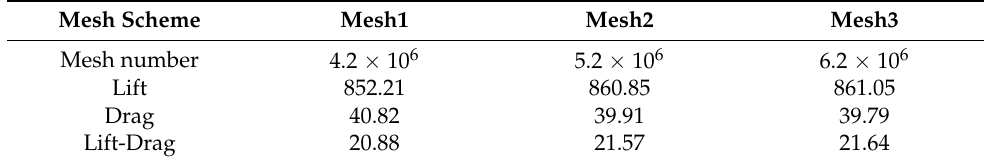
Table 2. Lift-to-drag under different mesh number.